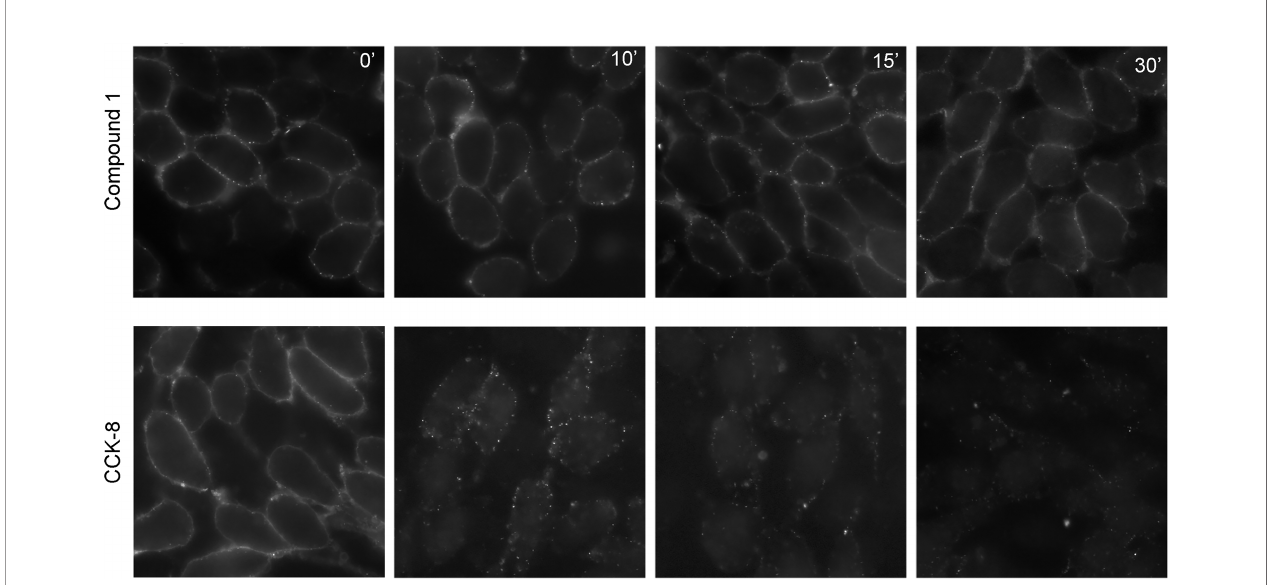
FIGURE 3 | Impact of Compound 1 on CCK1R internalization. Shown are time courses of CCK1R internalization, re fl ected as loss of cell surface receptor, stimulated by exposure to 10 m M Compound 1 (top series) or 1 m M CCK-8 (bottom series). After exposure of the CHO-CCK1R cells to the ligands at 37°C, cells were cooled to 4°C and surface receptor was quanti fi ed by probing with alexa 488 -CCK. Compound 1 had no signi fi cant impact on the cadre of cell surface receptor, while CCK-8 stimulated prompt receptor internalization. Shown are the representative images from three independent experiments.